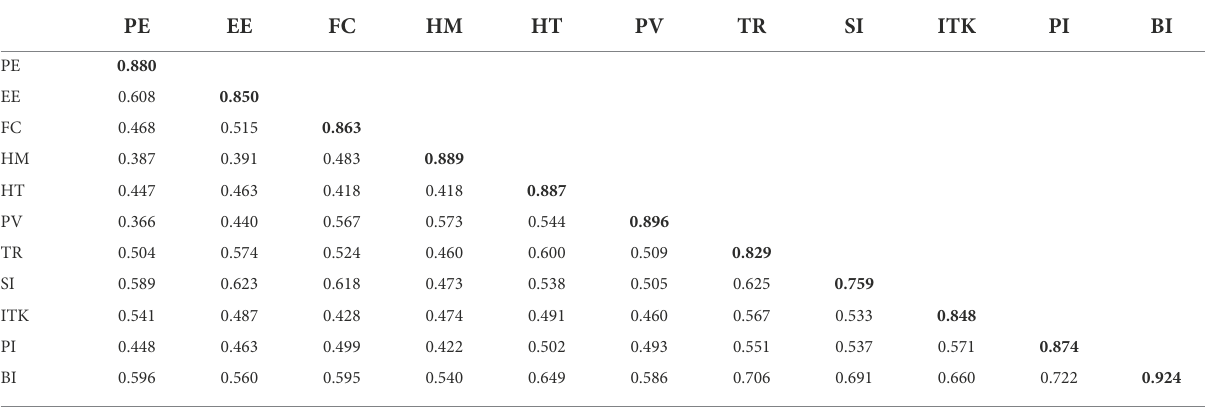
TABLE 4 Discriminant validity of the constructs.